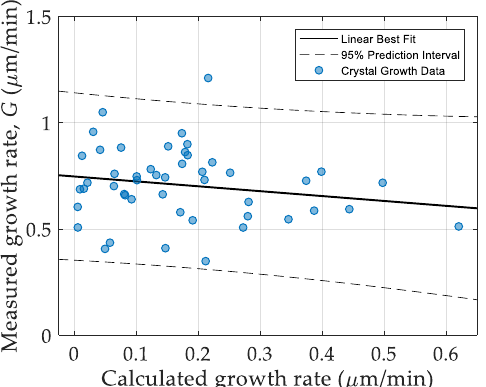
Figure 7. The measured growth rate of the crystals in Figure 6 versus the calculated growth rate of the same crystals based on the division of the image in Figure 6. Processes 2019 , 7 , x FOR PEER REVIEW